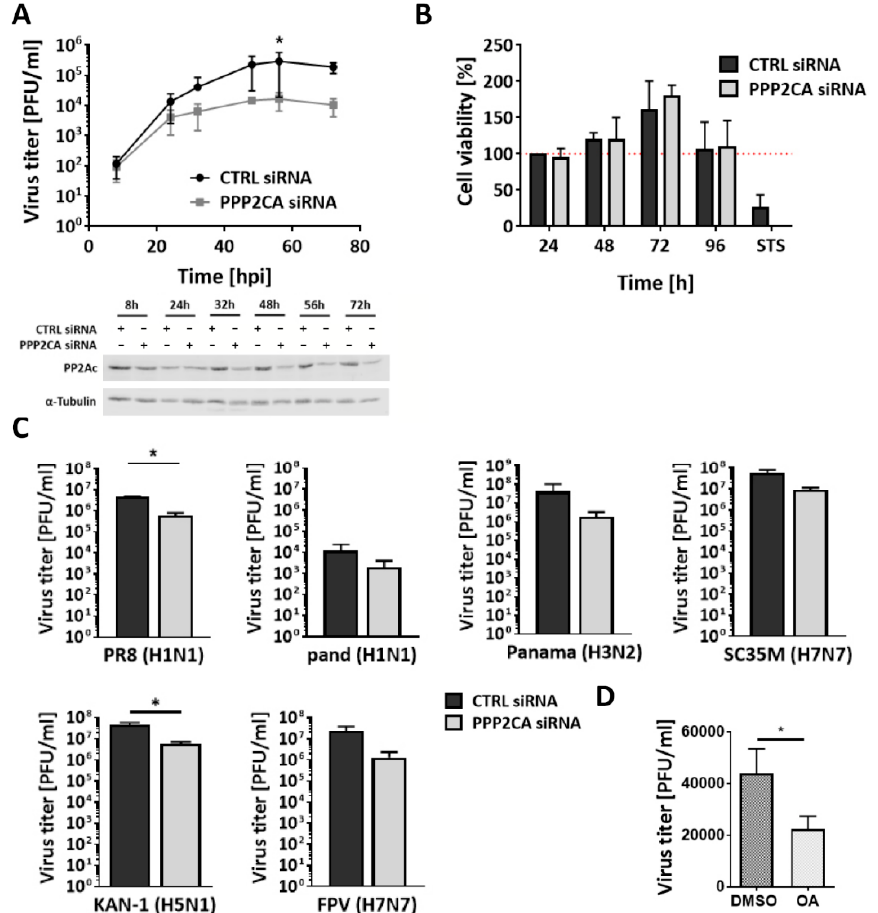
Figure 1. Cellular PP2A is required for efficient IAV replication. ( A ) A549 cells were infected with IAV strain A/WSN/33 (H1N1, WSN) at a multiplicity of infection (MOI) of 0.01, 24 h after siRNA-mediated knockdown (KD) of PP2Ac. Virus-containing supernatants were collected at the indicated time points. The amount of infectious particles was titrated with standard plaque assays. KD efficiency was visualized via Western blotting. ( B ) Cytotoxic effects of the PP2Ac KD were excluded via 3-(4,5-dimethylthiazol-2-yl)-2,5-diphenyltetrazolium bromide (MTT)-based cell viability assay with 1 µM staurosporin (STS) used as positive control. ( C ) A549 cells were infected for 24 h with IAV strains A/Hamburg/04/09 (pand, MOI = 0.1), A/Puerto Rico/8/34 (PR8, MOI = 0.1), A/Panama/2007/99 (Panama, MOI = 0.1), A/SC35M (SC35M, MOI = 0.01), A/Thailand/KAN-1/2004 (KAN-1, MOI = 0.001) and A/FPV/Bratislava/79 (FPV, MOI = 0.001) 48 h after siRNA-mediated KD of PP2Ac. The amount of infectious particles was titrated with standard plaque assays. ( D ) A549 cells were infected with WSN (MOI = 1). Five hpi, 100 nM okadaic acid (OA) or solvent CTRL (DMSO) was added. Supernatants were collected 9 hpi. The amount of infectious particles was titrated with standard plaque assays. ( A – D ) Data are represented as means + standard deviation (SD) of three independent experiments with three biological replicates. Statistical significance was analyzed using two-way ANOVA ( A , B ) or unpaired two-tailed t-test ( C , D ) with * p < 0.05.